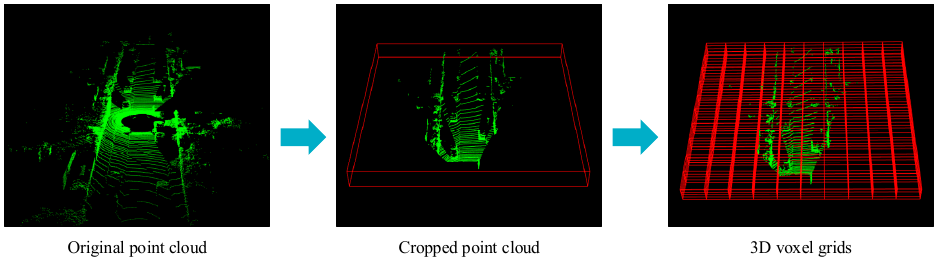
Figure 2. Voxelization of point cloud. Firstly, the original point cloud is cropped according to the fixed size L × W × H m 3 , and then the cropped point cloud is further transformed into 3D voxel